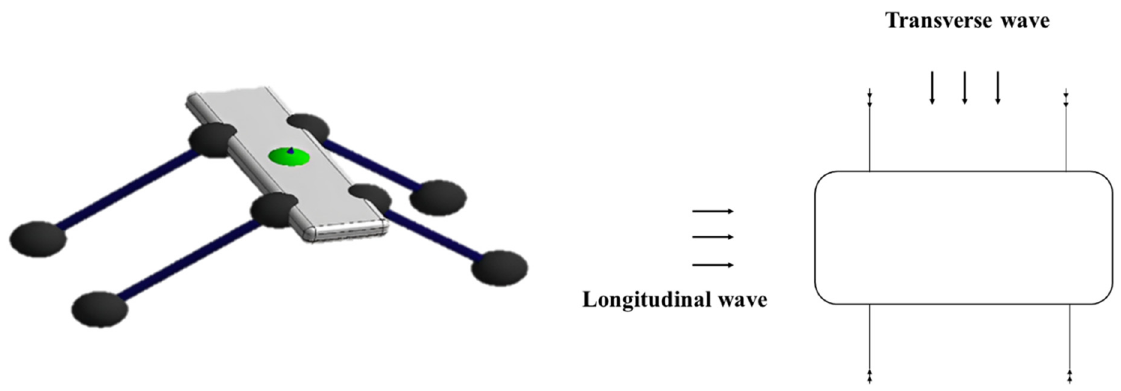
Figure 9. floating bridge unit anchorage and wave position.